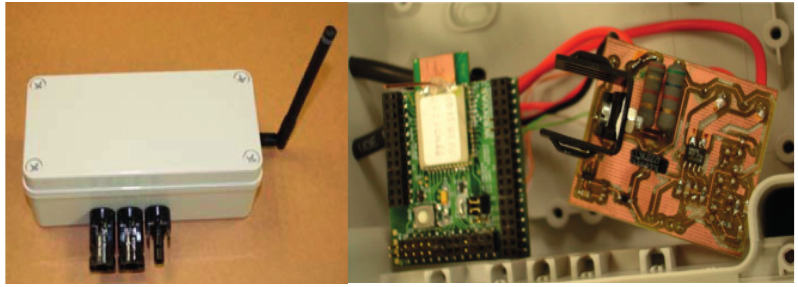
Figure 5. Sensor node. DC-voltage and current